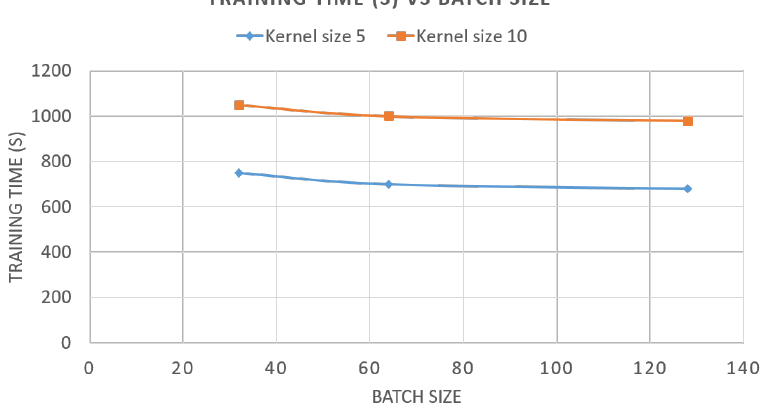
Figure 13. Comparison between the total training time and the number of hidden layers for the CNN when fixing the kernel size to 5 (blue) and 10 (orange).